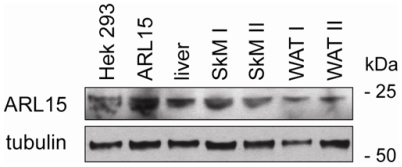
Western blot showing ARL15 expression in insulin-responsive tissues in humans with α-tubulin as a loading control.HEK293 = untransfected HEK293 cells; ARL15 = HEK293 cells transiently expressing wild type human ARL15. SkM = skeletal muscle; WAT = white adipose tissue.